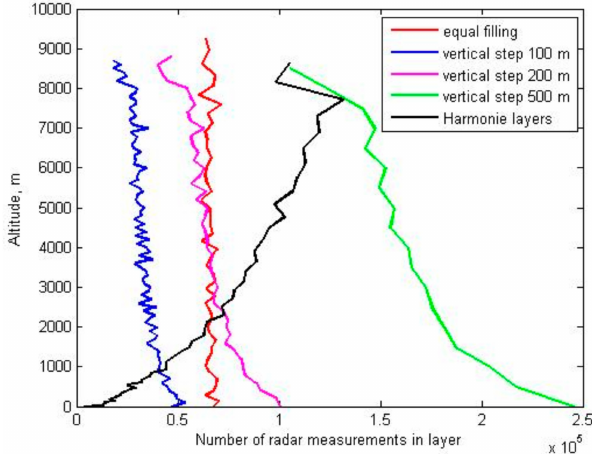
Figure 3. Filling-in the layers by radar data depending on the type of vertical step